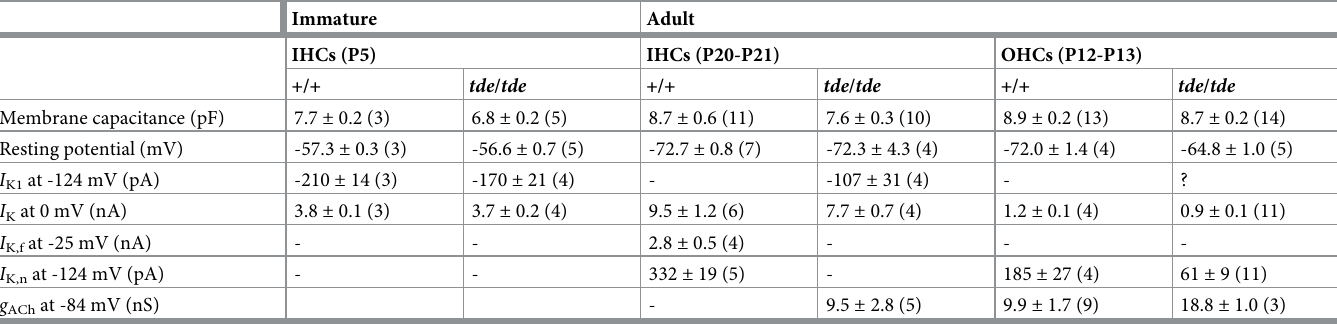
Table 2. Properties of immature and adult OHCs from Tasmanian Devil